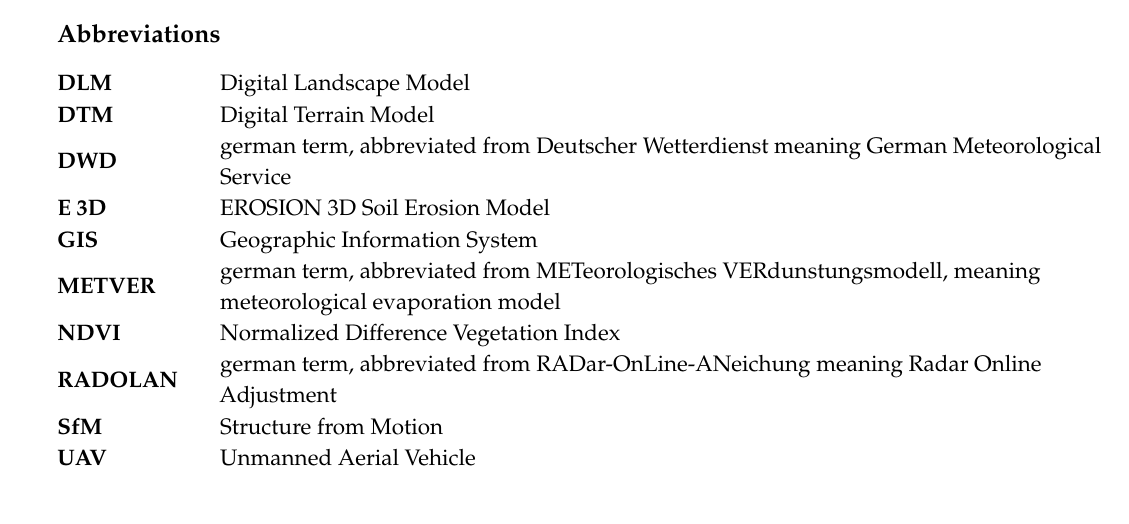
Table S1: Parameterization of the study